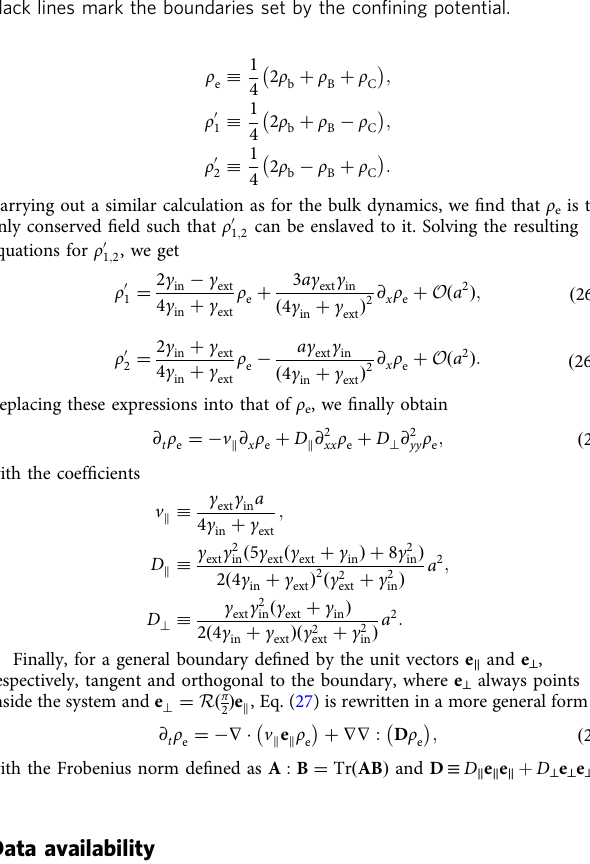
Fig. 5 Snapshots of a simulated trajectory with four counter rotating vortices. The trajectory starts at r = 0 (center) and the color labels the rescaled time Dt / R 2 with D the particle diffusivity. When t ≪ R 2 / D the particle has only explored a small portion of the available domain ( a ), such that it encounters the external boundaries only at larger times ( b ), while for t ≫ R 2 / D its trajectory covers all the disk of radius R ( c ). In all panels the black lines mark the boundaries set by the con fi ning